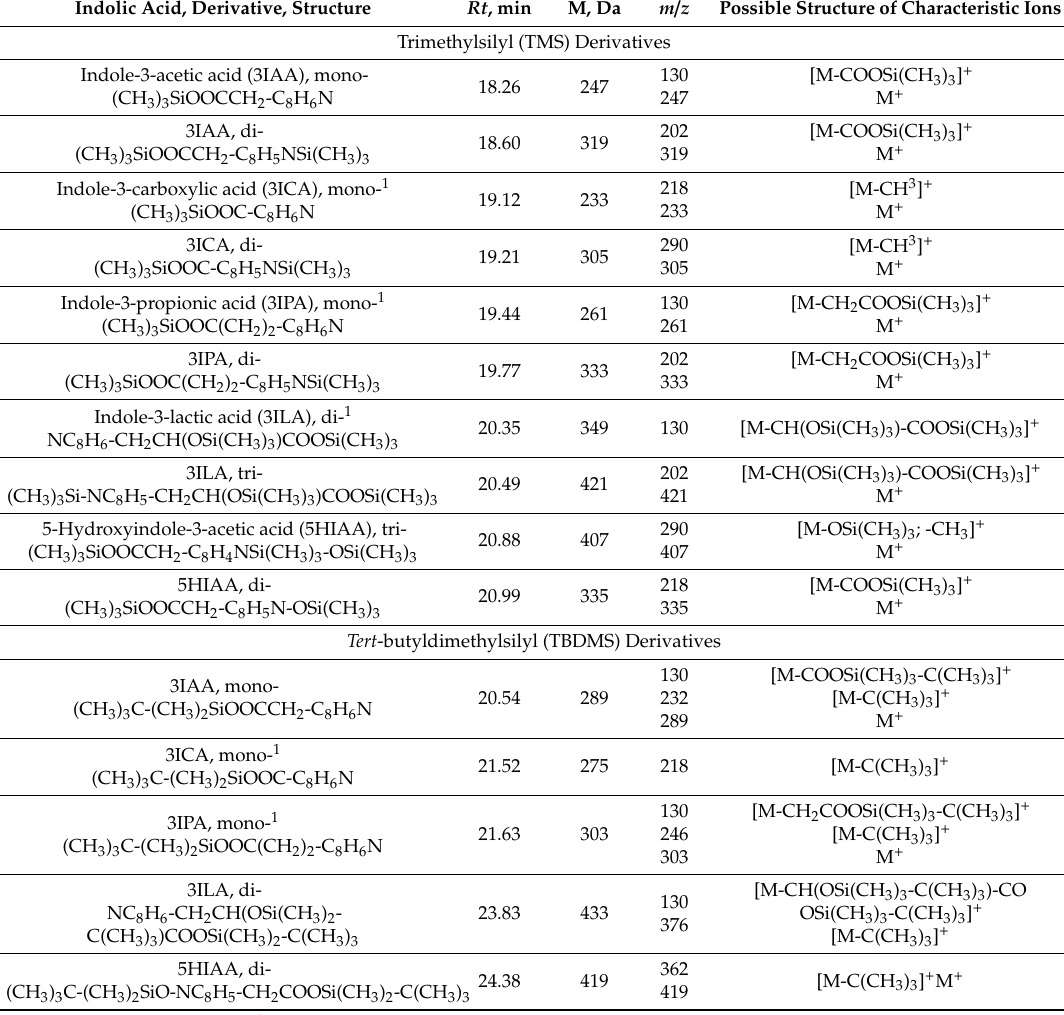
Table 1. Retention times ( Rt ), m / z values and possible structure of characteristic ions of indolic acid derivatives (M + - molecular radical